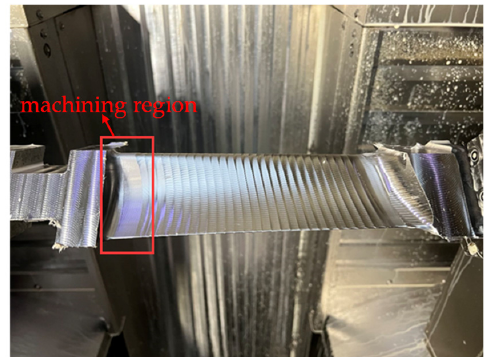
Figure 14. Blade for experimental tests.